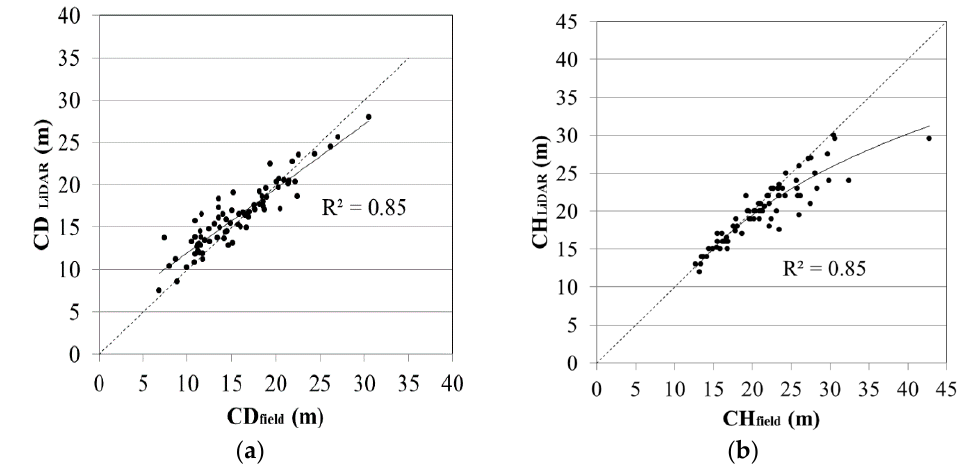
Figure 11. Scatterplots of ( a ) LiDAR-derived crown diameter and field measurements; and ( b ) LiDAR-derived canopy height and field measurements. The dashed lines are the 1:1 equivalence between measured and derived values and the solid lines the best-fit regression curves (liner and polynomial, respectively).